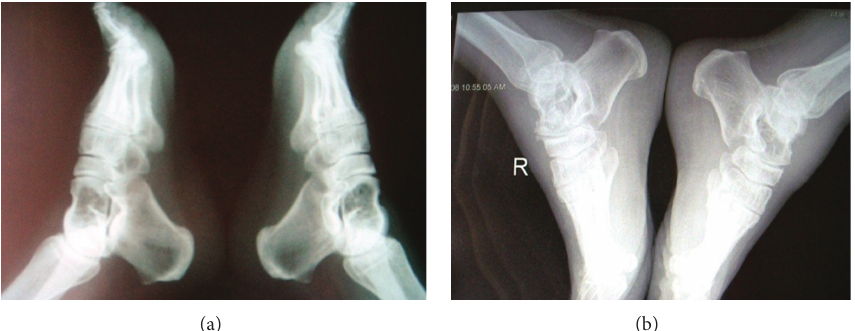
Figure 1: (a) Lateral radiographs of bilateral ankles showed multiple lytic lesions with sclerotic rims in both talus. (b) Lateral radiographs of bilateral ankles showed multiple lytic lesions with sclerotic rims in both talus.